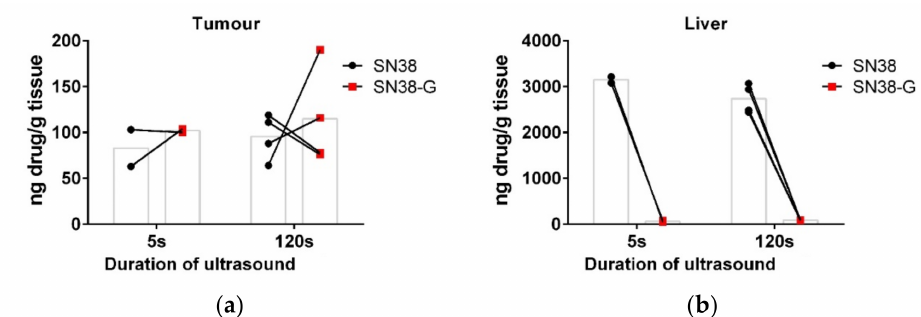
Figure 2. Increasing the duration of the ultrasound trigger. The effect of increasing the ultrasound trigger from 5 s to 120 s after bolus injection on drug delivery (SN38) and metabolism (SN38-G) 30 min later. Linked data points show the results from individual mice, with the bar in grey showing the mean. No difference was apparent between 5 s ( n = 2) and 120 s ( n = 4) for either SN38 or SN38-G in tumour ( a ) or liver ( b